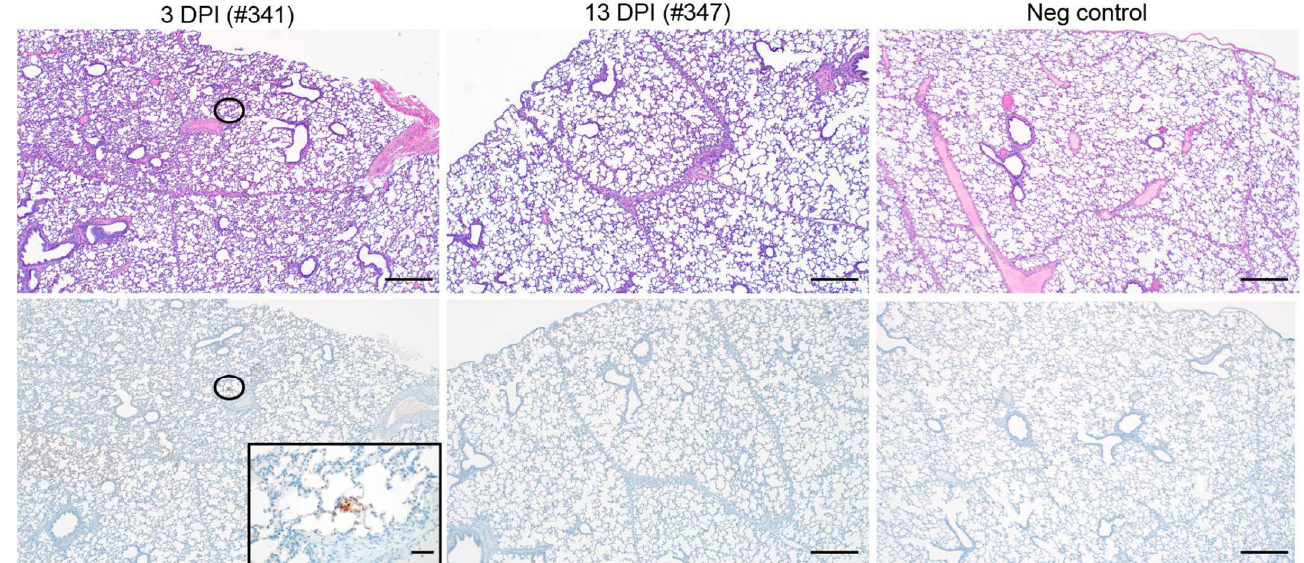
Figure 2. Pathology parameters of SARS-CoV-2 infected 3-week-old pigs. SARS-CoV-2 infected young pigs were euthanized on 3 DPI and 13 DPI, necropsied for tissue harvest and tissues prepared for histopathology. Negative control tissue samples were provided from previous age-matched studies. H&E did not find any SARS-CoV-2 related pathology, and IHC targeting SARS-CoV-2 nucleocapsid (N) protein remained negative. None of the pigs developed significant lung pathology, as shown here for one representative animal of the 3 DPI and 13 DPI. Except for a singular focus within a section of lung from pig #341 (3-DPI group), none of the lung samples showed SARS-2 immunoreactivity. The magnifications are indicated (40× and 400×).